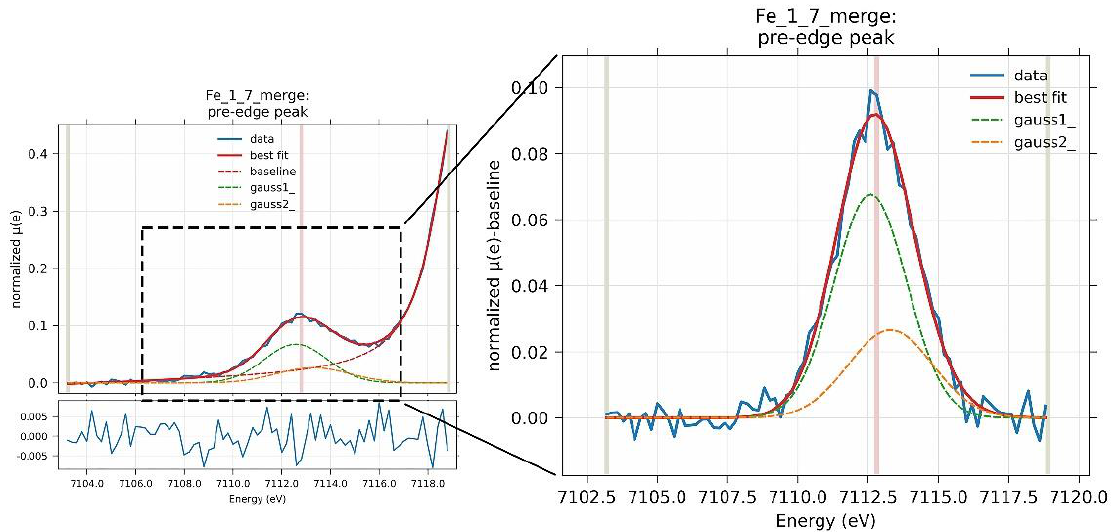
Figure 5. Representative of Fe pre − edge XANES spectra Figure 5 . Representative of Fe pre − edge XANES spectra composition .